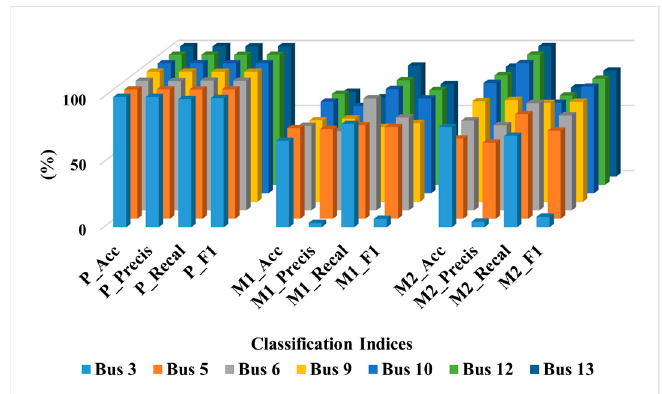
Figure 6. Harmonic locator indices including Acc , Precis , Recal and F 1 ‐ score for: P: the proposed method, M1: GALS [11], M2: SVD [8].